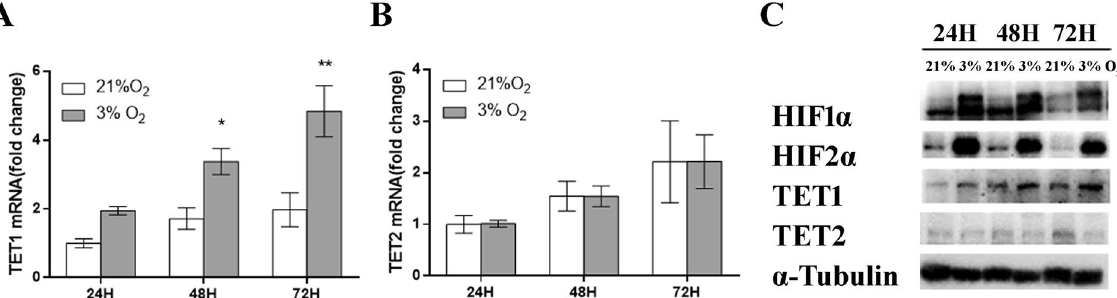
Figure-2. TET1 mRNA and protein expression is increased in cells exposed to 3% O 2 . JEG3 cells were cultured in 3% or 21% O 2 for 24 h, 48 h and 72 h. TET1 ( A ) and TET2 ( B ) mRNA expression was analyzed using qPCR. ( * P < 0.05, ** P < 0.01, one-way ANOVA) ( C ) The protein expression of HIF1 α , HIF2 α , TET1 and TET2 was detected by western blotting. α -Tubulin was used as the internal control.